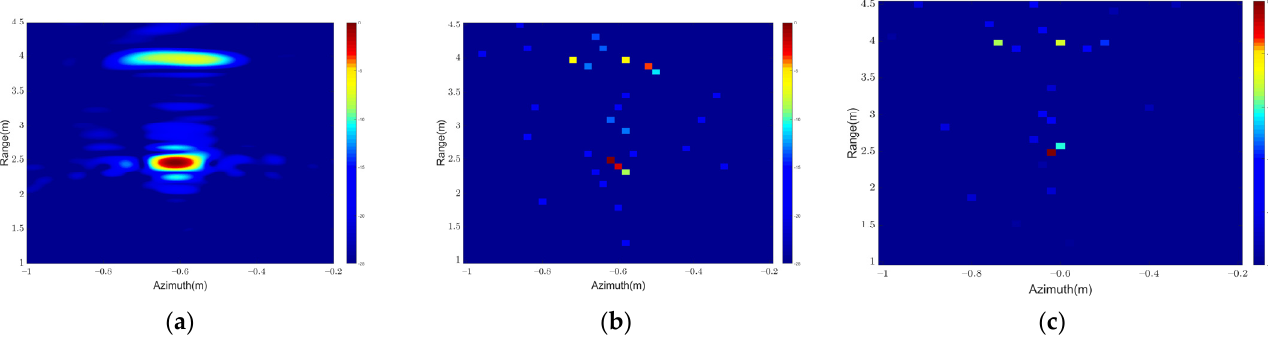
Figure 8. MIMO radar experiments results. ( a ) Result of BP. ( b ) Result without compensation of errors. ( c ) Result of the proposed method.